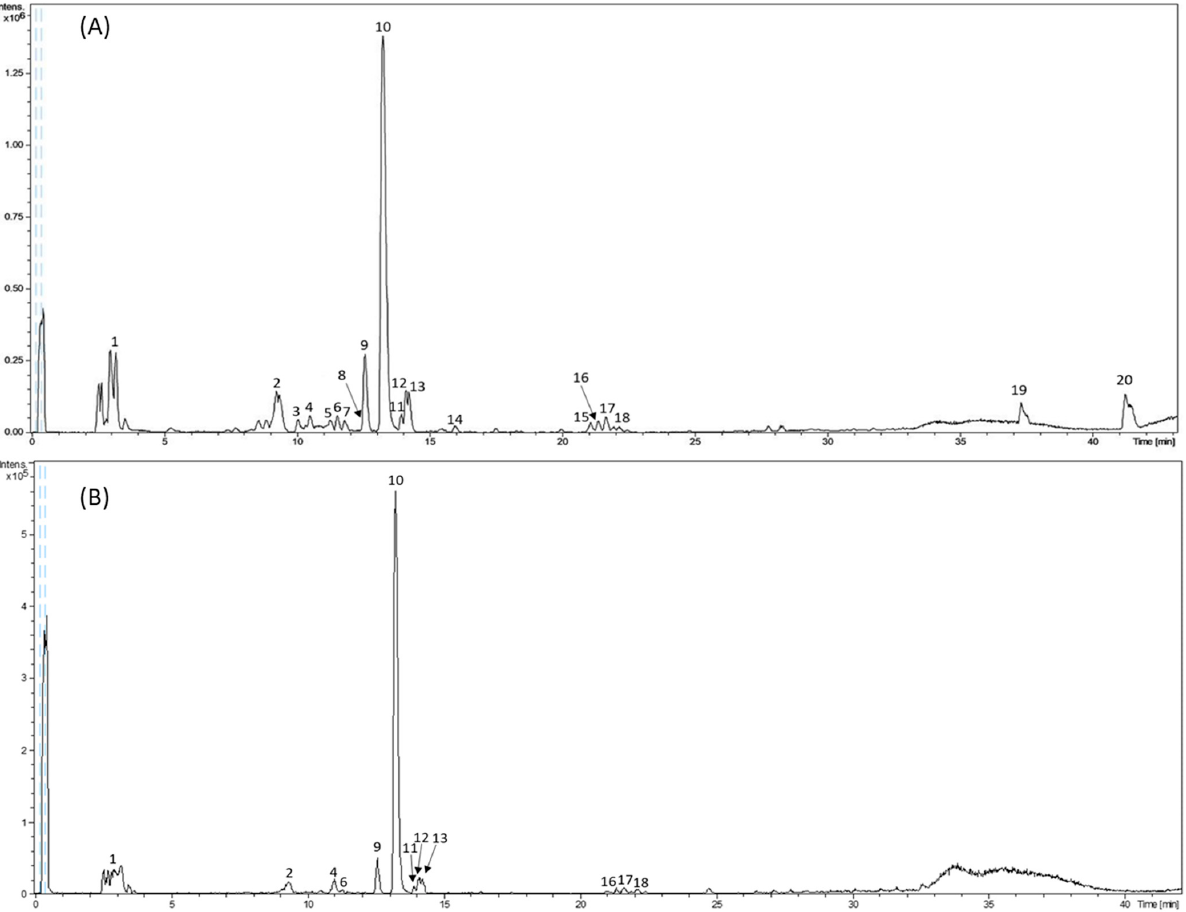
Figure 1. Representative base peak chromatogram of the HPLC–ESI-TOF-MS analysis of phenolic extracts from asparagus: ( A ) PLE 6, ( B ) SLE.